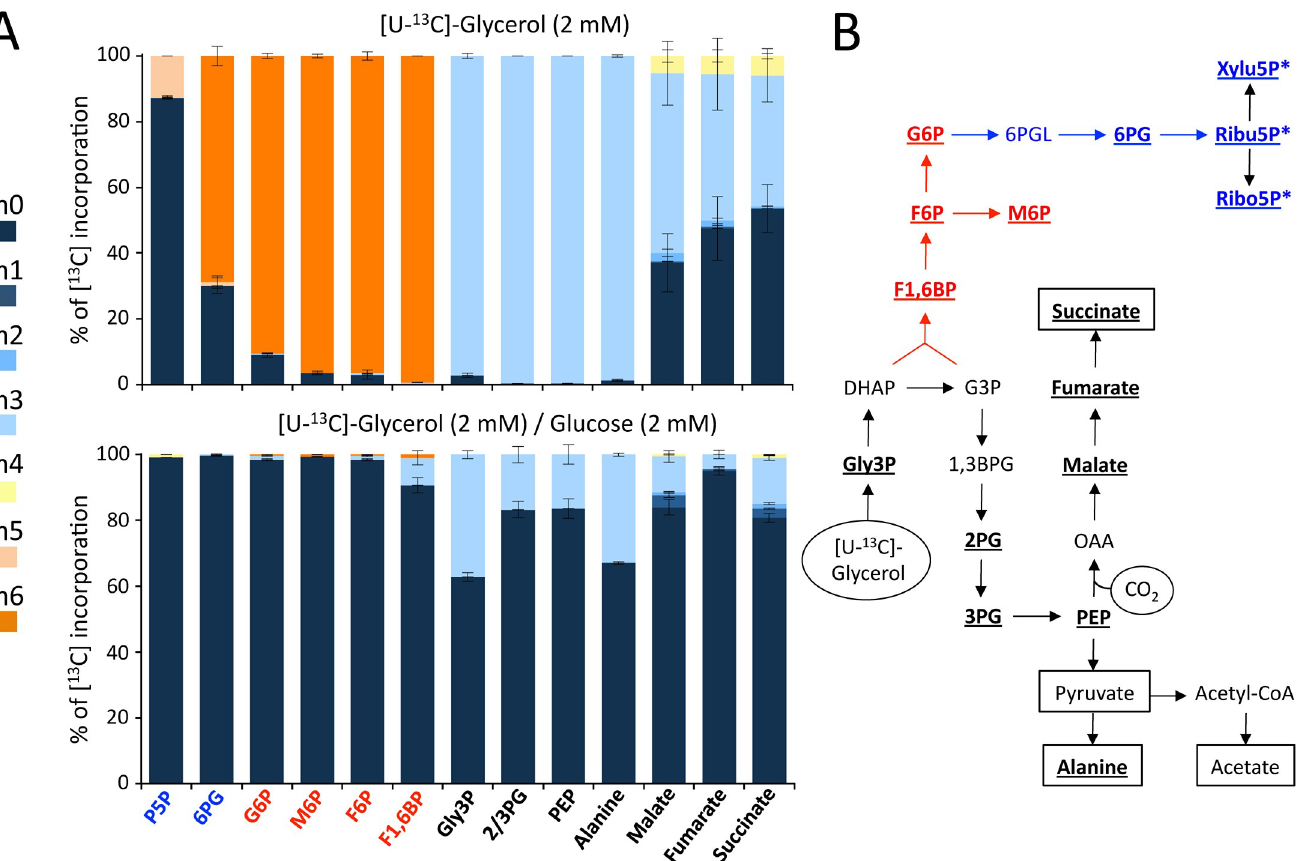
Fig 5. Incorporation of [U- 13 C]-glycerol into BSF intracellular metabolites. The 427 90–13 BSF parental cell line was incubated for 1 h in PBS containing 2 mM [U- 13 C]-glycerol alone or in the presence of 2 mM glucose (Panel A). The figure shows the 13 C-enrichment of key metabolites of the intermediate metabolism at 0 to 6 carbon positions (m0 to m6, colour code indicated, "mx" denotes metabolites in which x of the atoms are 13 C instead of 12 C) with 13 C expressed as percentage of all corresponding molecules (MID; Mass Isotopomer Distribution). Error bars indicate means ± SD of 3 biological replicates. The metabolic scheme in panel B represents the enzymatic reactions leading to production of the analysed metabolites from glycerol metabolism (bold faced and underlined ones). Gluconeogenesis and mannose 5-phosphate production are shown in red and part of the pentose phosphate pathway is in blue. The carbon sources incorporated in the metabolism network ([U- 13 C]-glycerol and CO 2 ) are circled and the excreted end products are boxed. For abbreviations see Fig 1, other abbreviations are: Ala, alanine; M6P, mannose 6-phosphate; 2/3PG, 2- or 3-phosphoglycerate (these two metabolites are undistinguished by IC-MS/MS); 6PG, 6-phosphogluconate; 6PGL, 6-phosphogluconolactone; P5P, pentose 5P including ribose 5-phosphate (Ribo5P), ribulose 5-phosphate (Ribu5P) and xylulose 5-phosphate (Xylu5P), which are undistinguished by